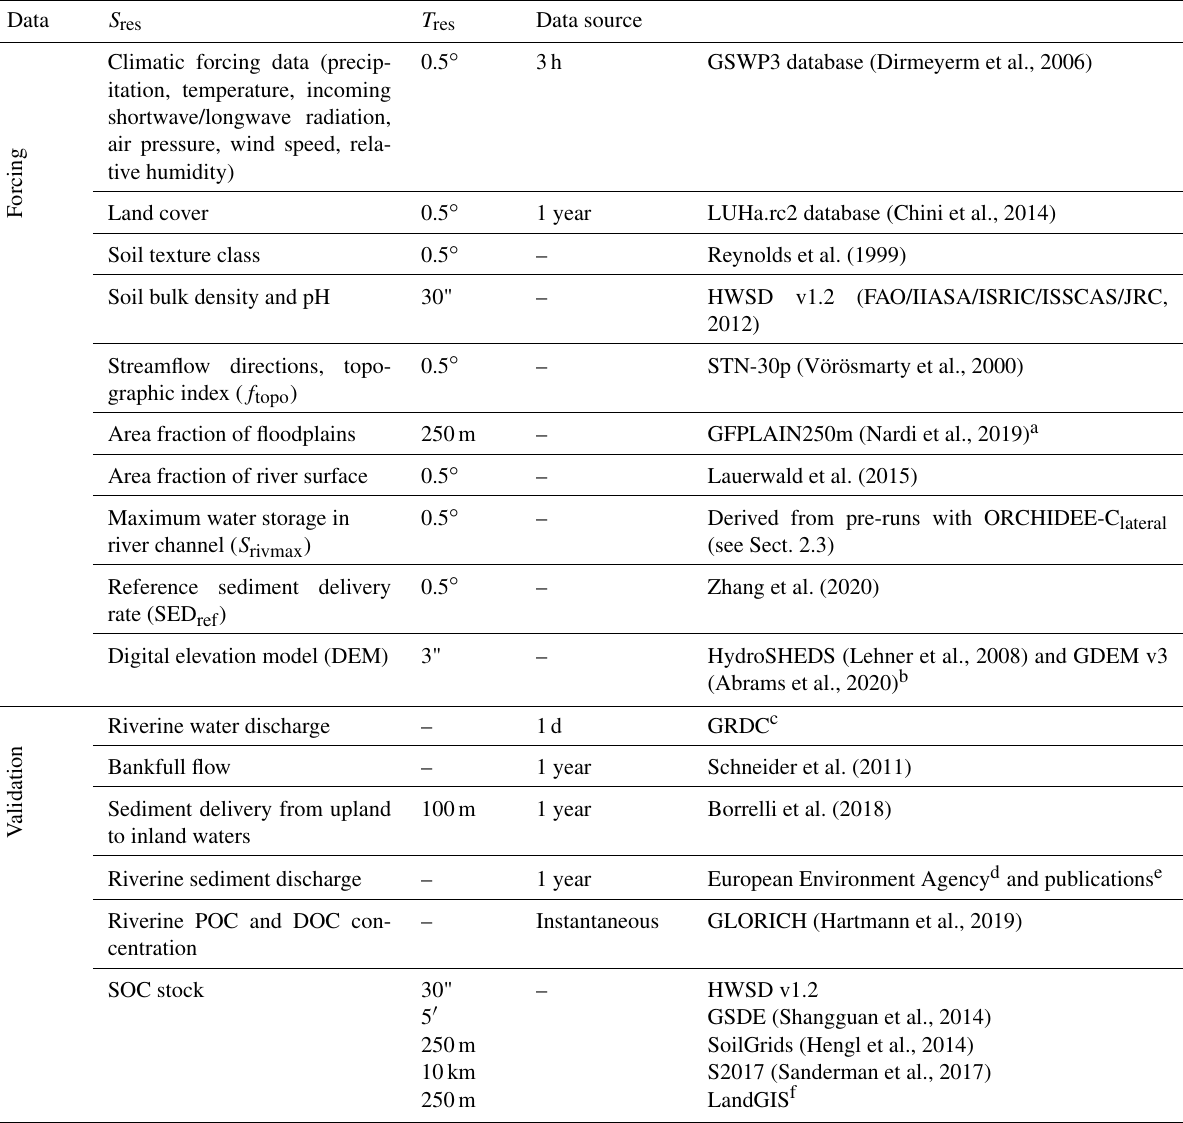
Table 1. List of forcing data needed to run ORCHIDEE-C lateral and the data used to evaluate the simulation results. S res and T res are the spatial and temporal resolution of the forcing data,